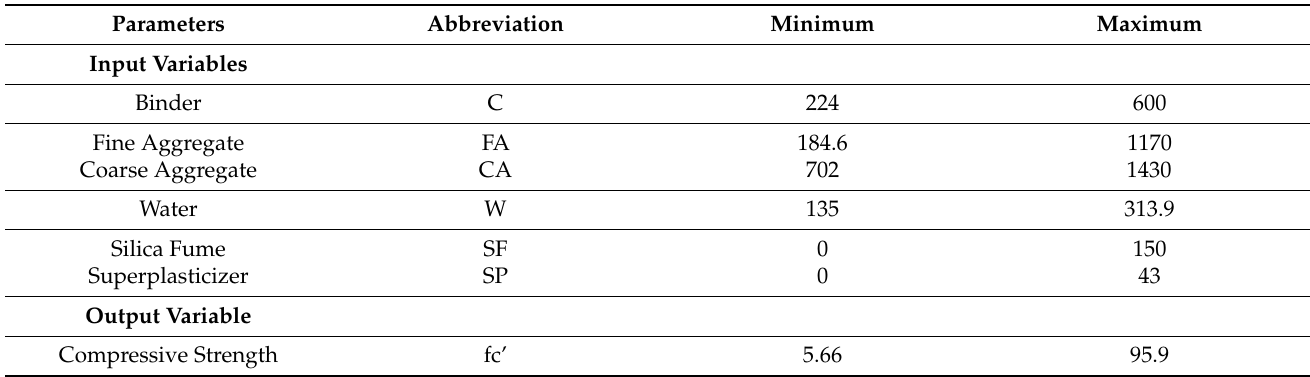
Table 4. The Maximum and Minimum Range of Silica Fume Concrete Data for Compressive Strength.